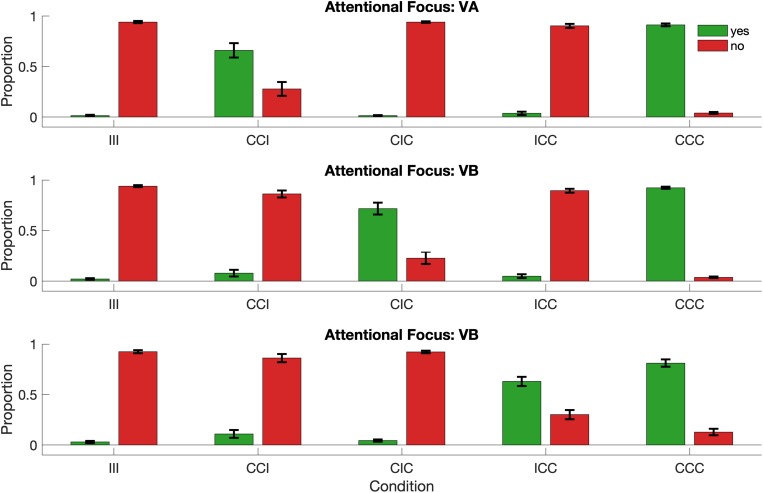
Response bias in the data (proportion scale). Data are displayed according to the actual response of the participant (“YES” and “NO”) for all conditions in all groups. While in some conditions subject responded with “NO” more frequently, there was no overall evidence for a general response bias in the data.